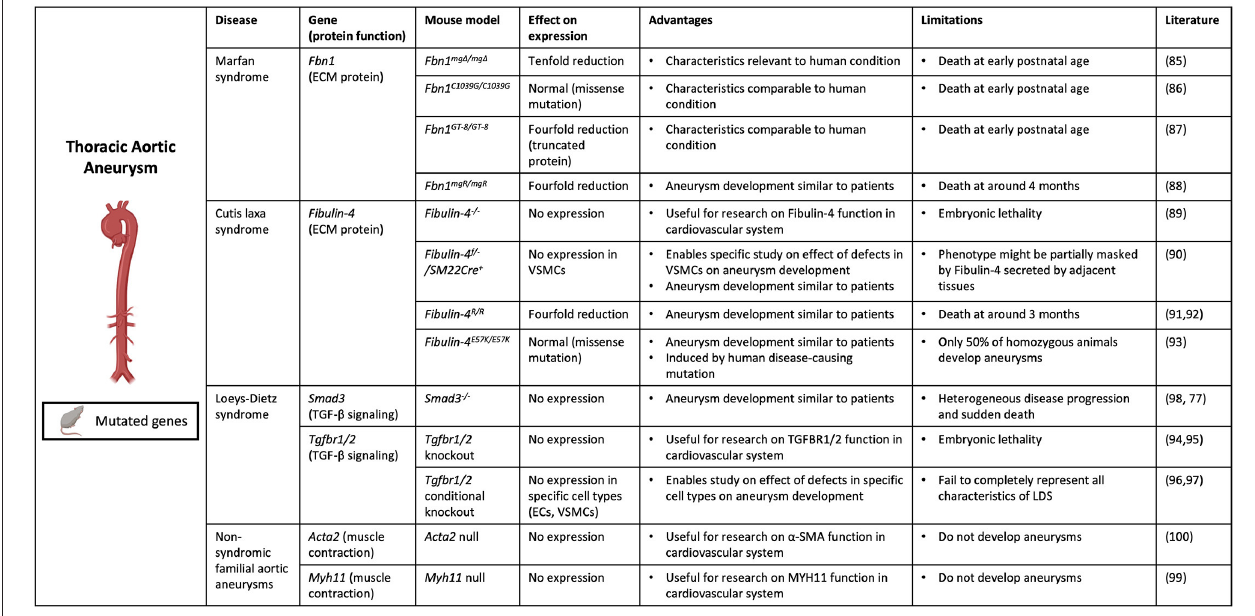
FIGURE 2 | Contemporary murine models for TAA. Thoracic aortic aneurysm can be modeled in mice through genetic modification of specific genes ( Fbn1, Efemp2 (Fibulin-4), Smad3, Tgbr1/2, Acta2 and Myh11 ) involved in aneurysm formation. (Picture created with